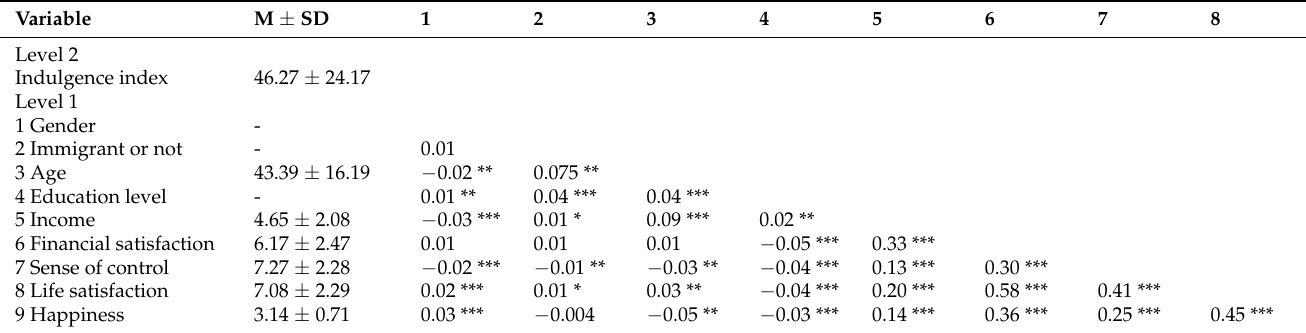
Table 1. Description and correlation analysis in study 1 ( N = 49,097).